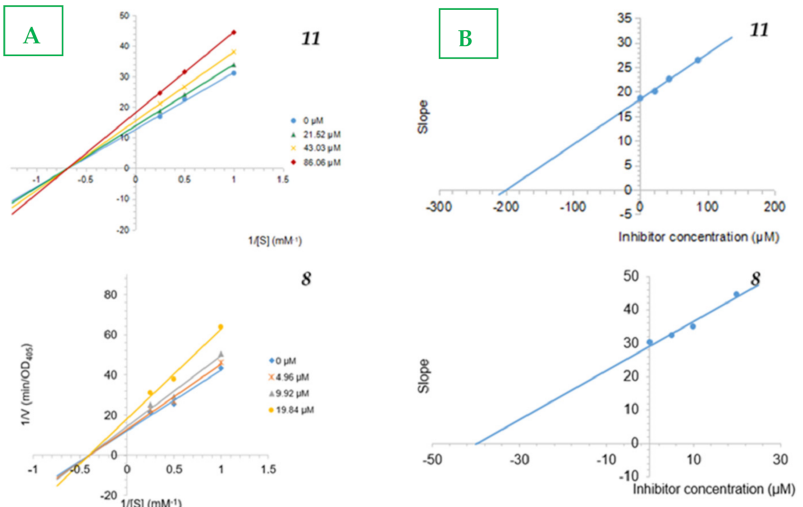
Figure 2. Lineweaver–Burk plot for α -glucosidase inhibition by compounds 11 and 8 ( A ) and the secondary plot of slope vs. the inhibitor concentration ( B